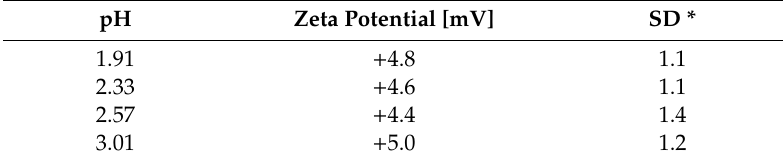
Table 1. The zeta potentials of the bacterial cell (ionic strength 10 − 3 M NaCl).